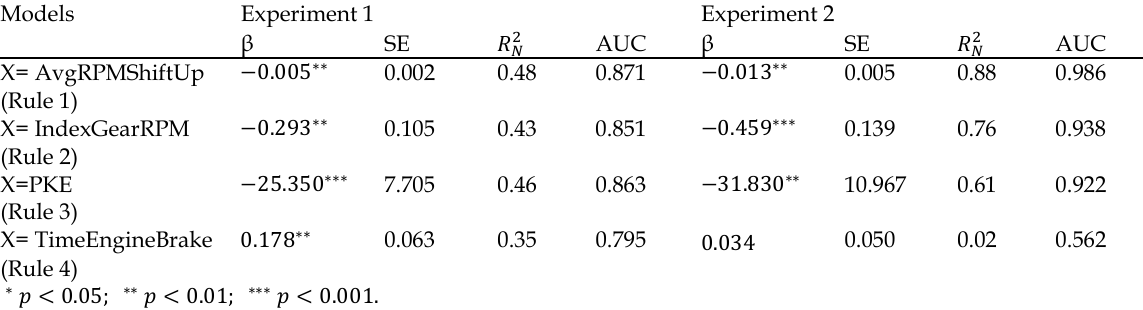
Table 6. Logistic regression models for 70km/h speed